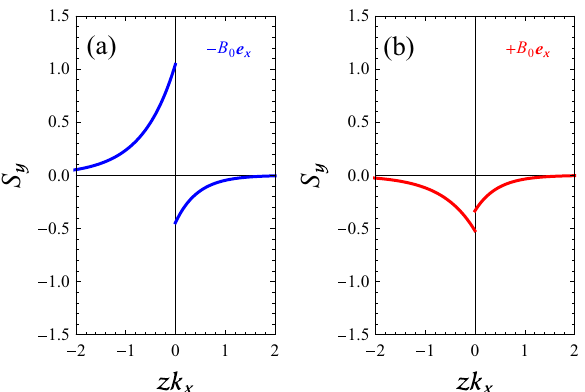
Figure 8. Normalized profile S y ( z ) of SMP modes of a flat magnetized electron gas-vacuum interface, as obtained from Eq. (17) when k y / k x labeled points in Fig. 3b. ( a ) B 0